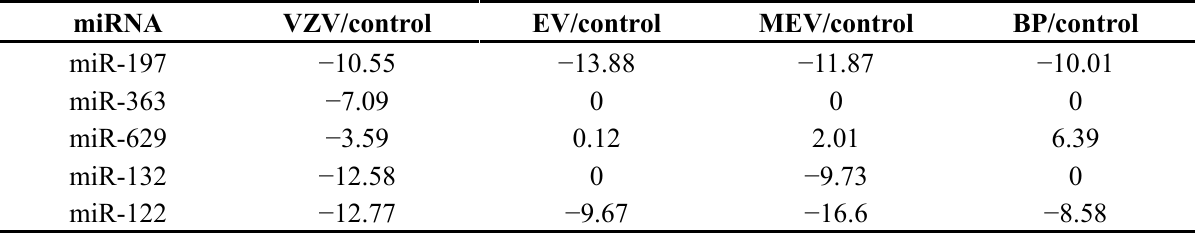
Table 3. The ∆∆Ct values of three miRNAs in VZV and various microbial infections compared with controls measured by